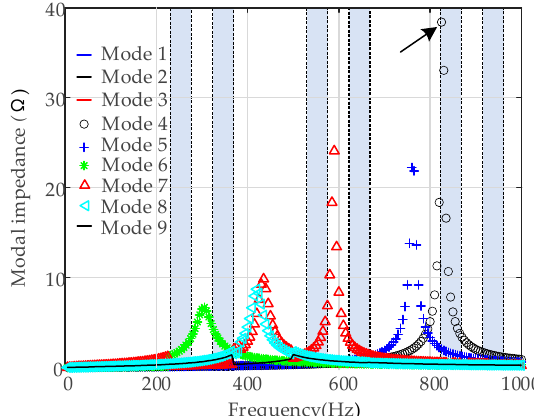
Figure 6. IEEE 9 − bus regional microgrid.